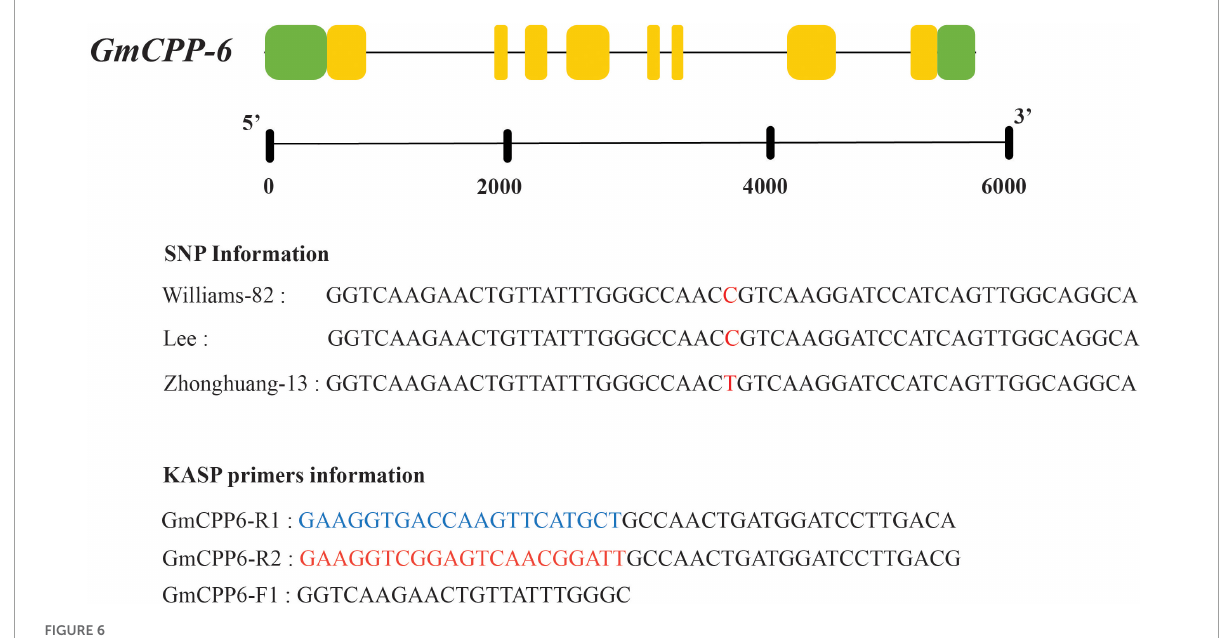
FIGURE6 Gene structure and KASP marker development for GmCPP-6 . Red colored alphabets indicated sequence polymorphism. Nucleotides color blue indicating FAM where nucleotides colored red indicating HEX.